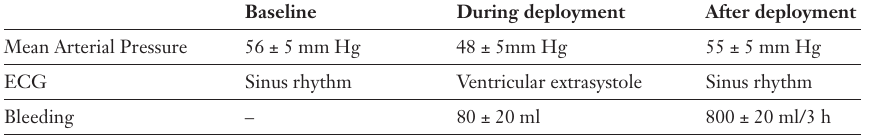
Cumulative results.